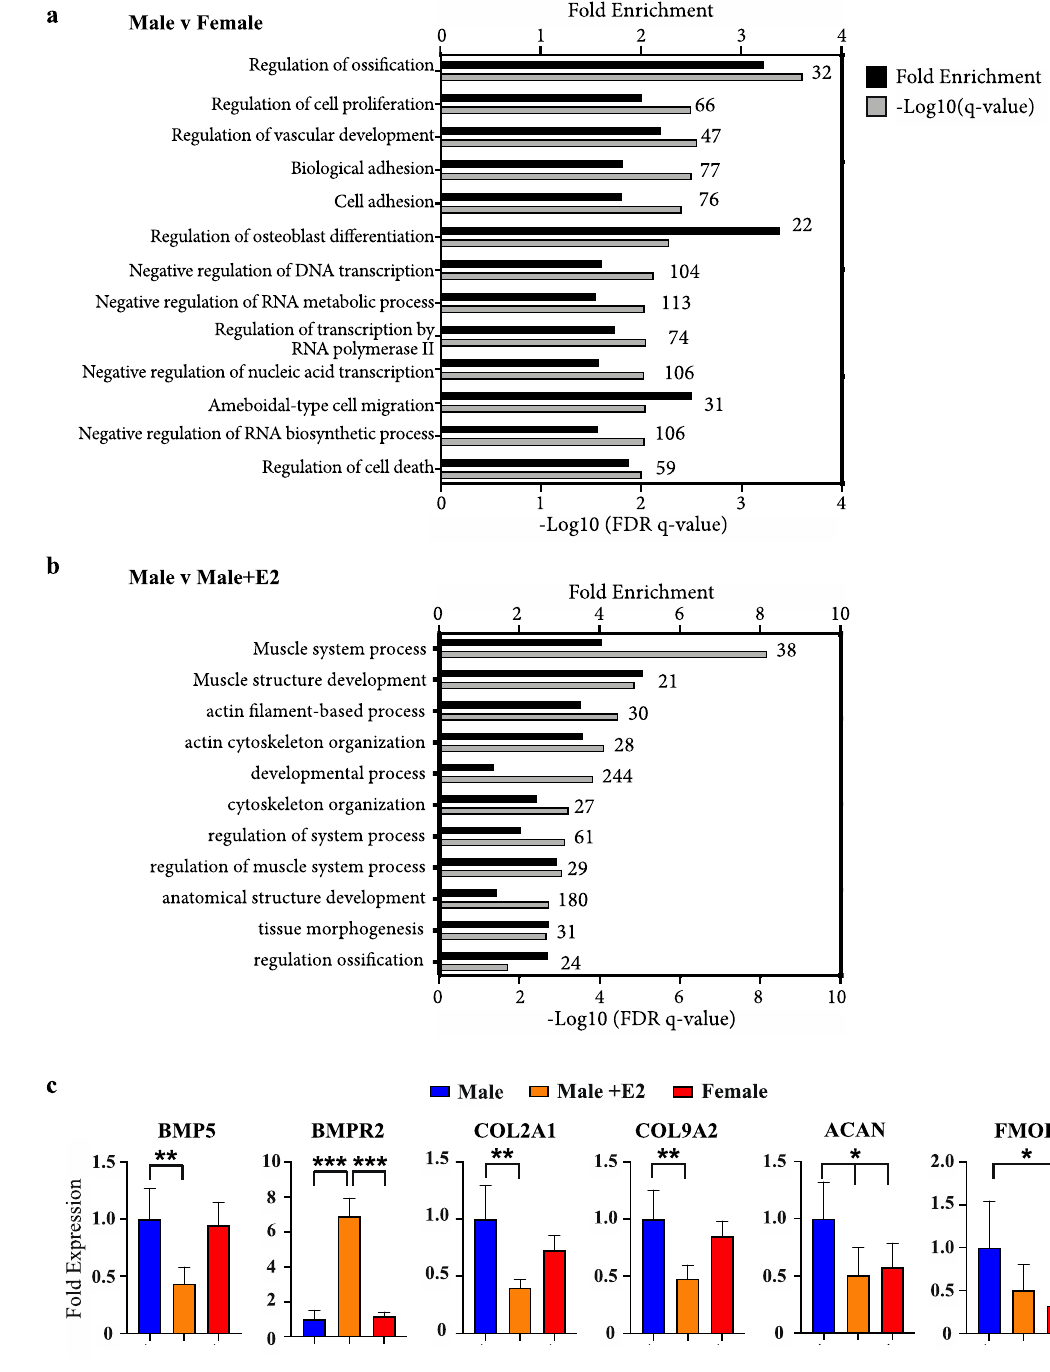
Figure 1. Enrichment of bone development ontologies in male versus female and males treated with oestradiol ( a ) Fold enrichment (black bars) and FDR q-values (grey bars) of process gene ontologies from differentially expressed genes between male and female phallus, or ( b ) male phallus with and without oestradiol treatment. Numbers above bars on graph indicate the number of enriched genes in that ontology ( c ) Representative bone / chondrocyte development genes and their relative levels in RNAseq data. ( n = 5 animals / group; mean +/ − s.d, * = < 0.05, ** = < 0.01, *** = <